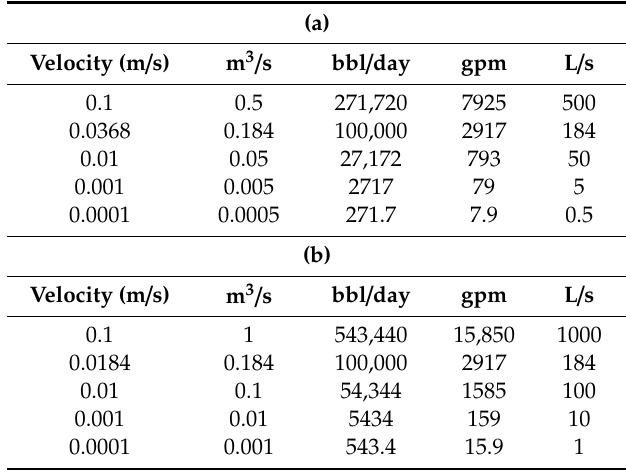
Table 2. ( a ) Well rate and fracture velocity correlations for fracture aperture 0.005 m (Base Case 1). ( b ) Well rate and fracture velocity correlations for fracture aperture 0.01 m (Base Case 2).